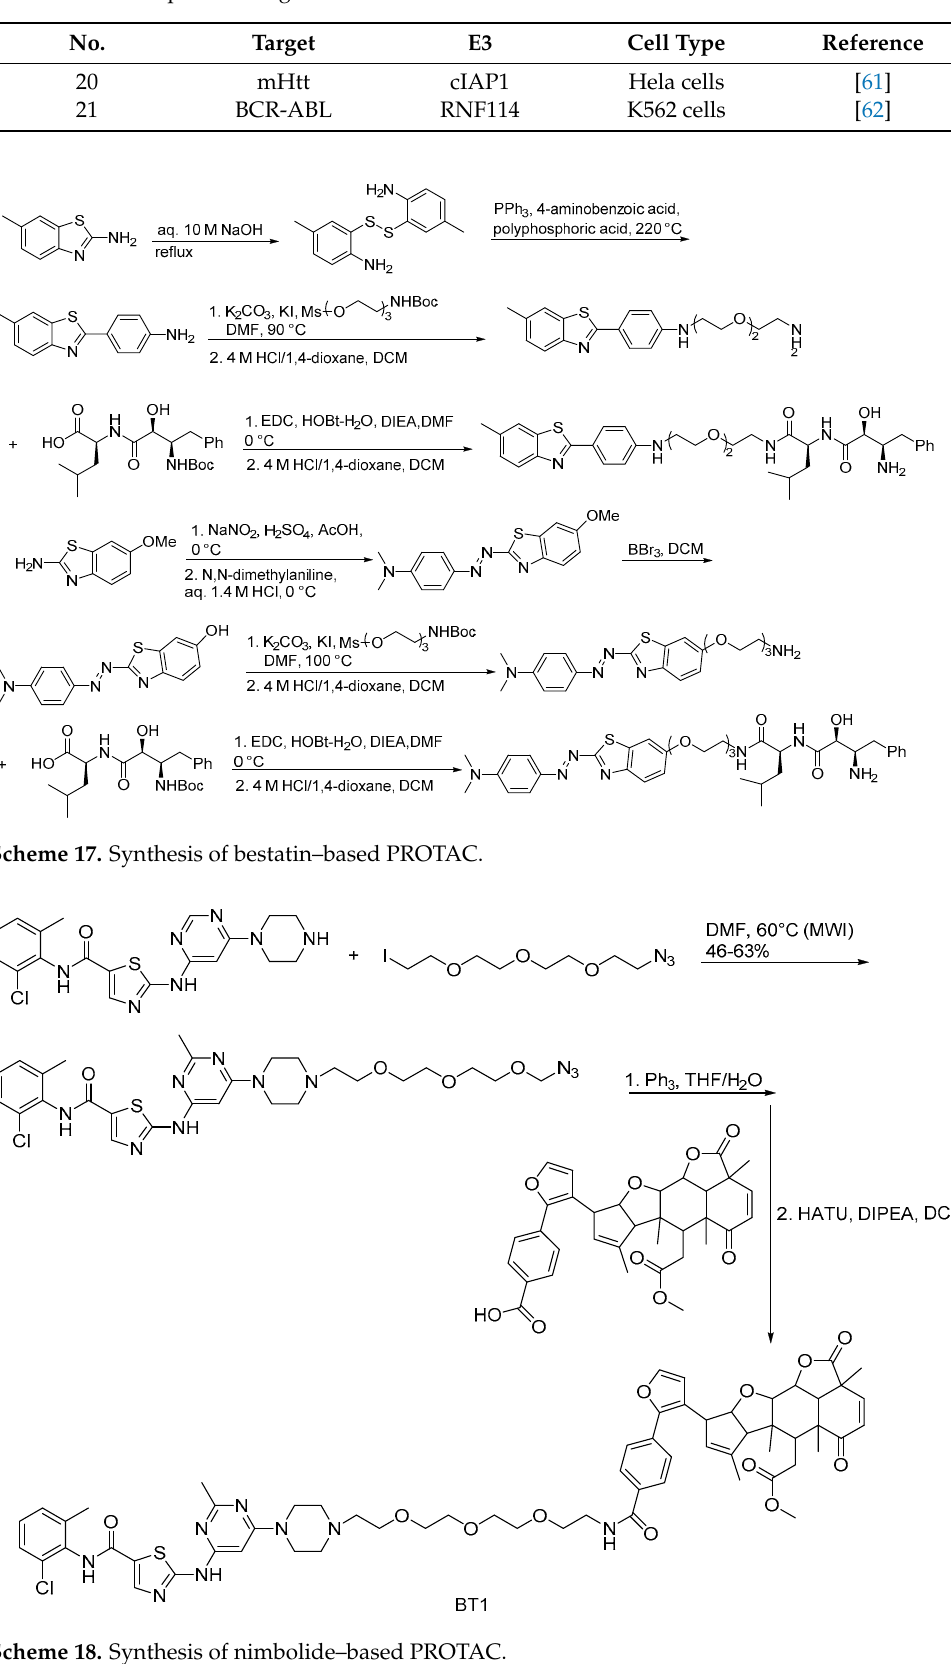
Table 10. Natural product targets